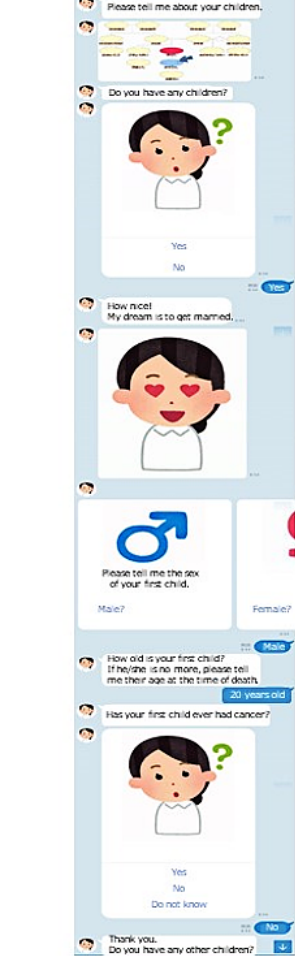
Figure 5. The interface of the chatbot. The LINE interface was used. The conversation in Japanese was translated into